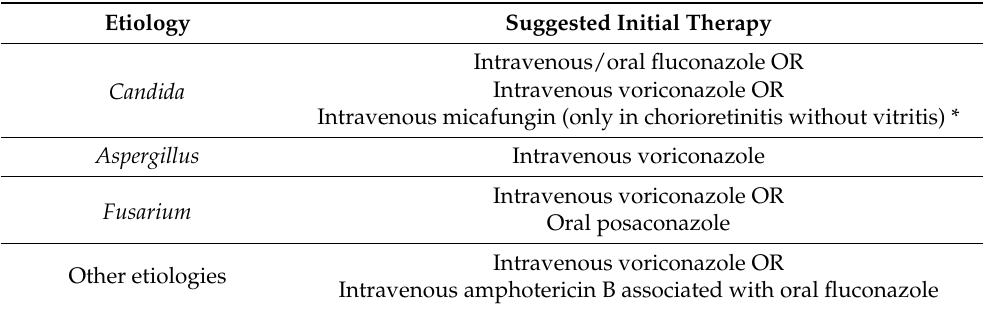
Table 3. Suggested initial therapy in fungal endophthalmitis (FE) cases were an etiologic agent has been identified, but antifungal susceptibility is yet unknown.